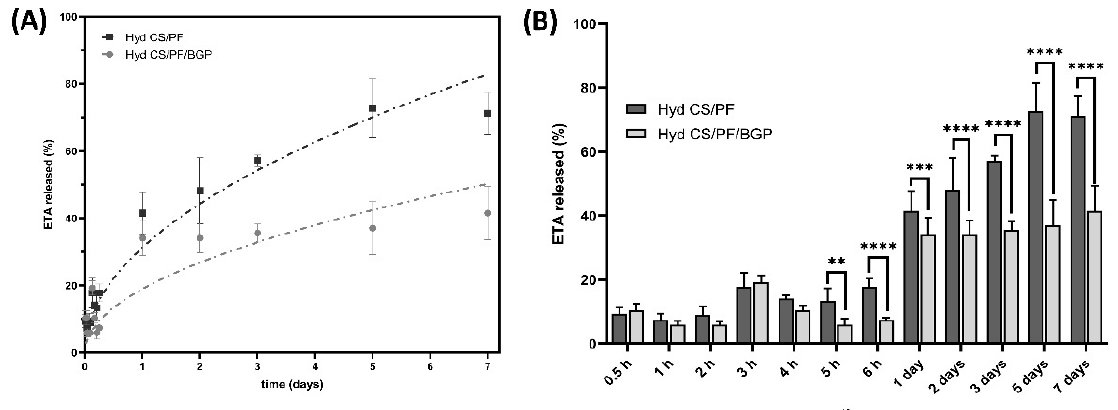
Figure 2. In vitro ETA release profile. ( A ) Release behavior of the ETA from CS/PF and CS/PF/BGP hydrogels. The error bars represent mean ± SD ( n = 3). ( B ) Comparison of the amount of ETA released at each time point. Values represent mean ± SD ( n = 3; two-way ANOVA, Sidak’s multiple comparisons test, ** p < 0.01, *** p < 0.001 and **** p < 0.0001).